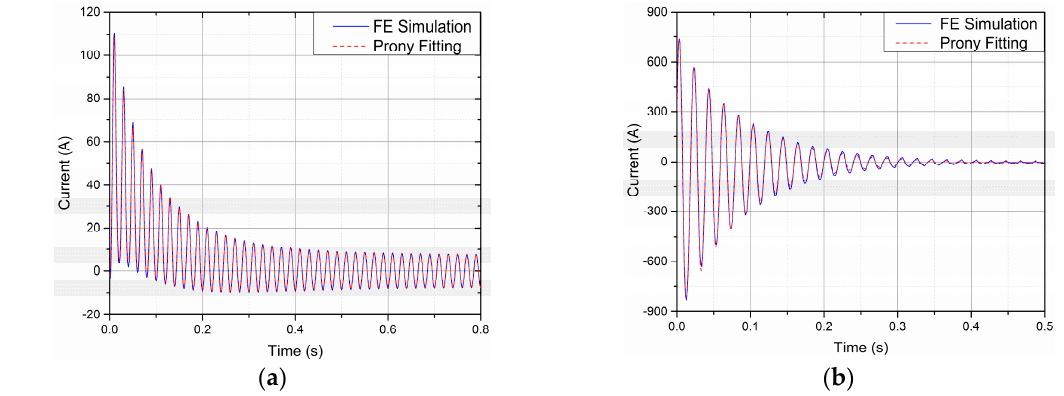
Figure 13. Comparison of current waveforms from time-stepping FE simulation and Prony fitting. ( a ) stator A phase winding current; ( b ) kQ winding current. Table 5. Modal identification of fitted current.